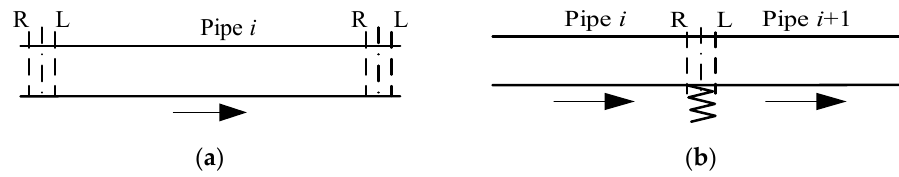
Figure 5. Transfer matrices of pipe. ( a ) Field transfer matrix. ( b ) Point transfer matrix.